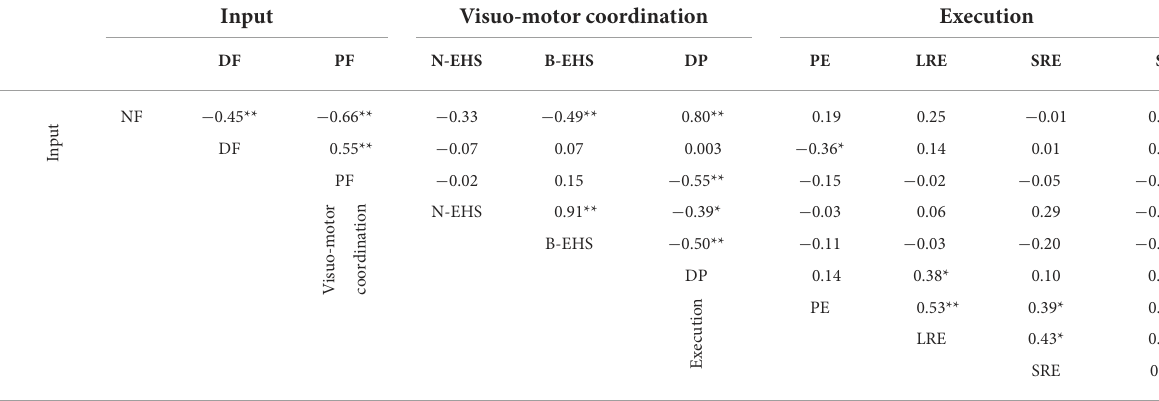
TABLE 5 The Spearman’s correlation coefficient among variables of Input, Visuo-motor coordination, and Execution.